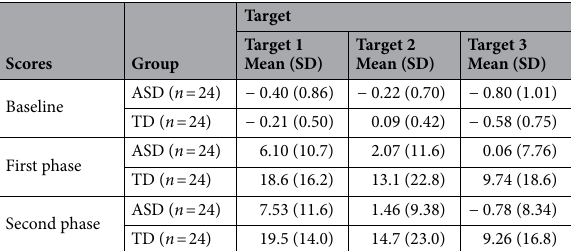
Table 1. Endpoint bias (degree) in all phases and target locations. ASD: autism spectrum disorder; TD: typically developing; SD: standard deviation.